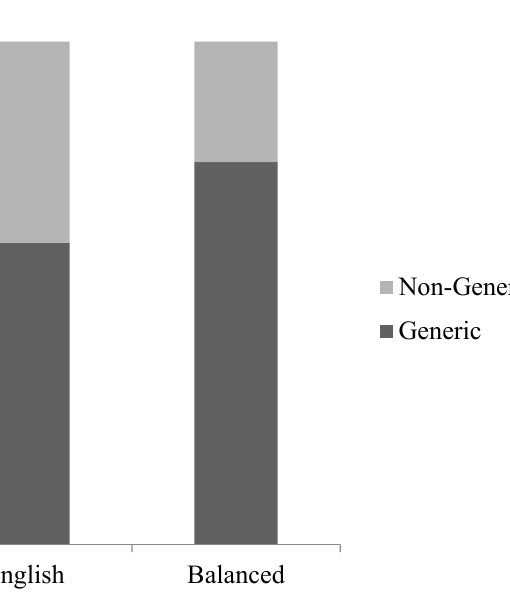
Figure 4. Interpretation of bare NPs, according to the amount of input.